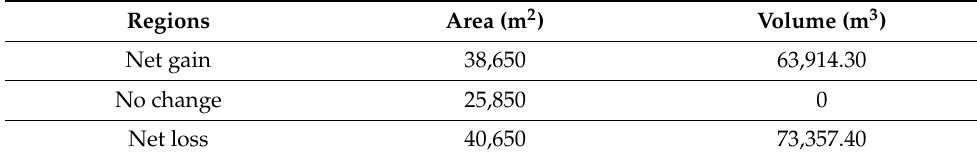
Figure 10. Map of the landslide showing volume loss (green colored area), volume gain (red colored area), and stable areas (grey color). Table 3. Calculation of the area and the volume of the regions, resulted from cut-fill